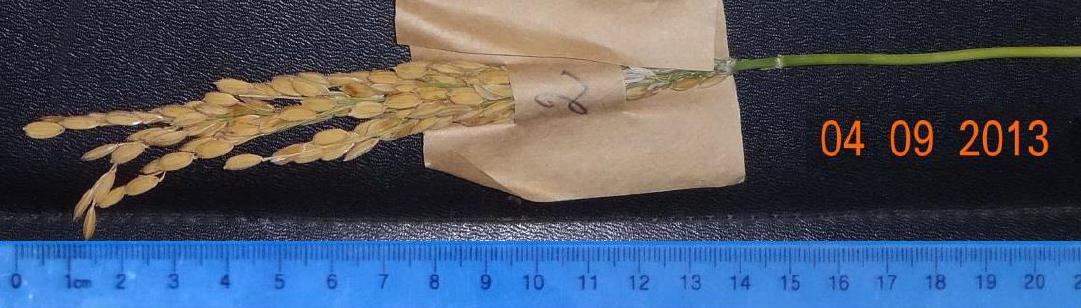
Figure 1. Panicle of the early-ripening line 1225 / 13.